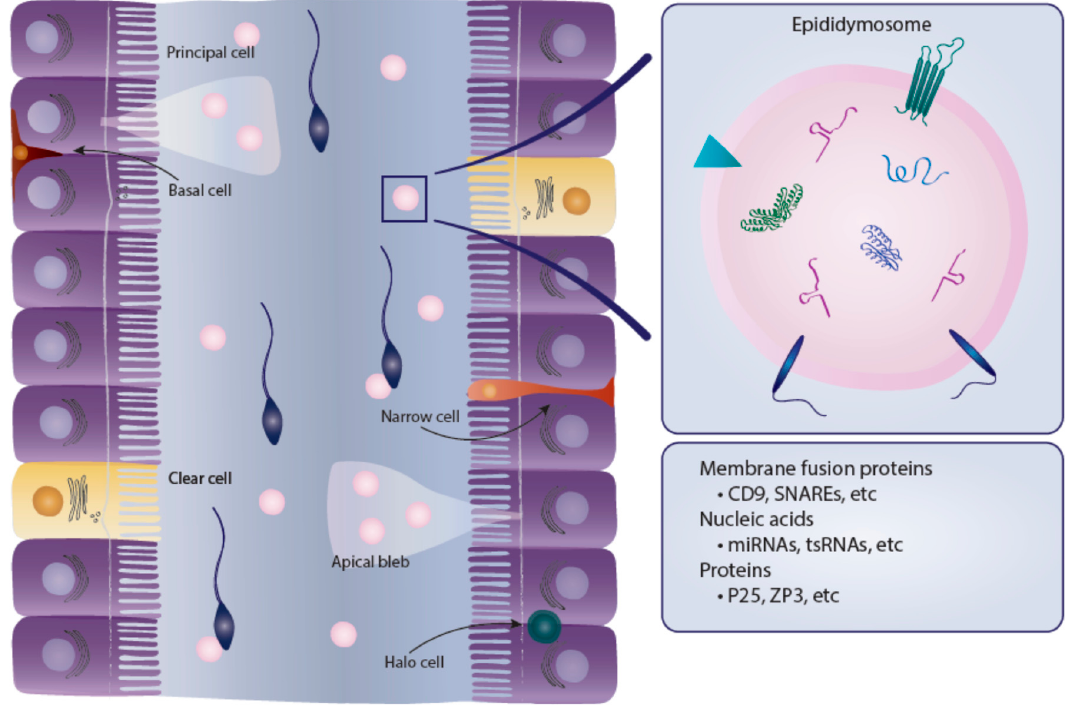
Figure 2. Epididymal internal structure and epididymosomes content.